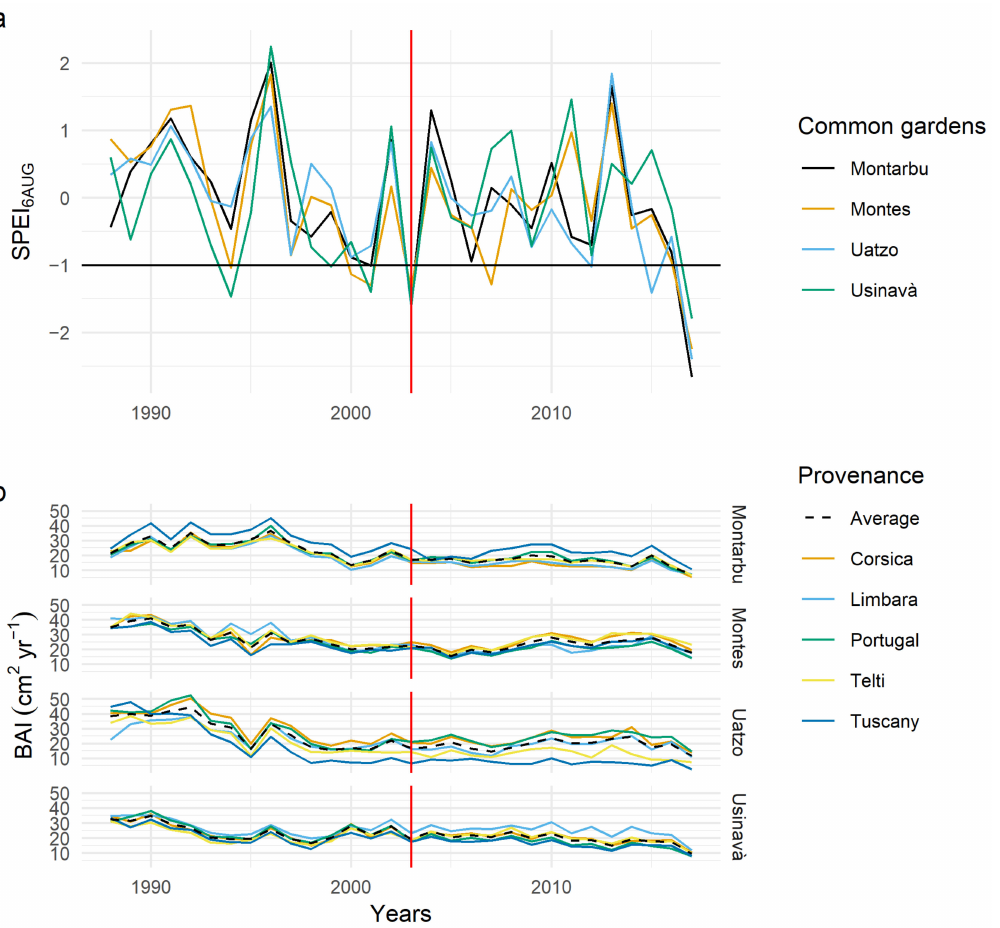
Figure 3. ( a ) SPEI value for August calculated on a timescale of six months to cover the growing period. The drought years were identified when this value was lower than − 1. ( b ) Annual growth pattern (BAI) of the five provenances and the mean for each common garden. The red vertical line indicates the year 2003.